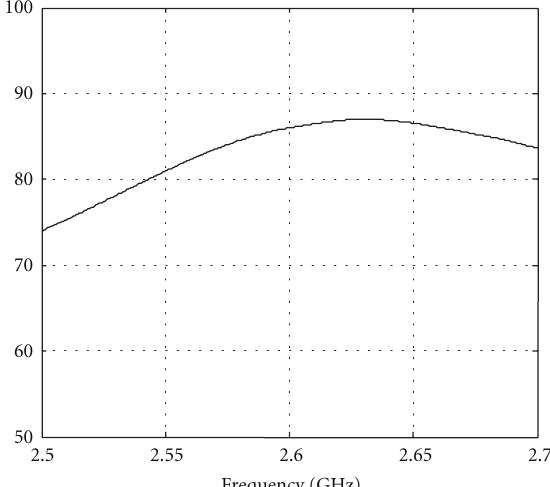
Figure 8: Simulated total e ffi ciency in the higher band for the optimized three bend endings antennas with added ground plane, and slot.